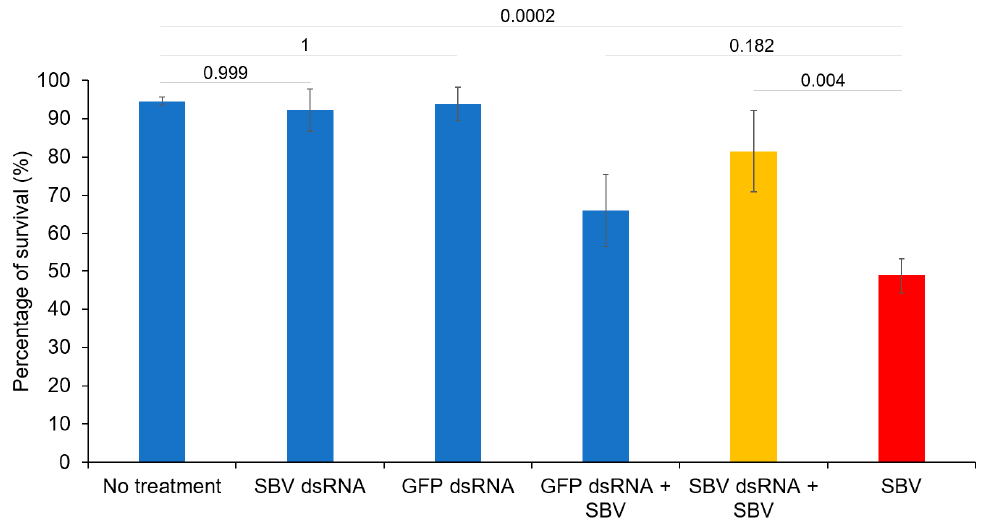
Figure 1. Treatment of sacbrood virus (SBV) using VP3 double-stranded RNA (dsRNA) in honey bee larvae reared in vitro. The survival rate of larvae in each group was calculated on the eighth day of the inoculation period based on three replicated trials. dsRNA of SBV VP3 and GFP was supplied to the healthy larvae in the “SBV dsRNA” and “GFP dsRNA” groups, respectively, to assess the safety of dsRNA to the larvae. dsRNA of each gene was also supplied to SBV-infected larvae to test the efficacy of SBV treatment (in the GFP dsRNA + SBV and SBV dsRNA + SBV groups). One SBV-infected group (SBV) and one healthy group did not receive dsRNA treatment (No treatment). Tukey’s pairwise comparison p values between the groups are shown. Table 1. Field application of double-stranded RNA (dsRNA) for the prevention of sacbrood virus